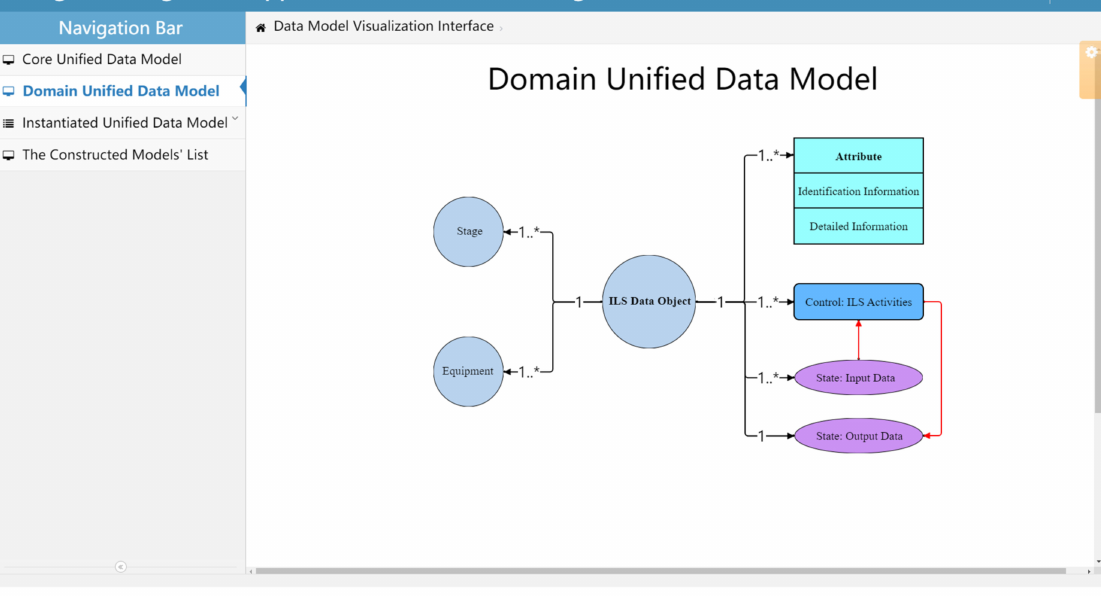
Figure 14. Domain unified data model